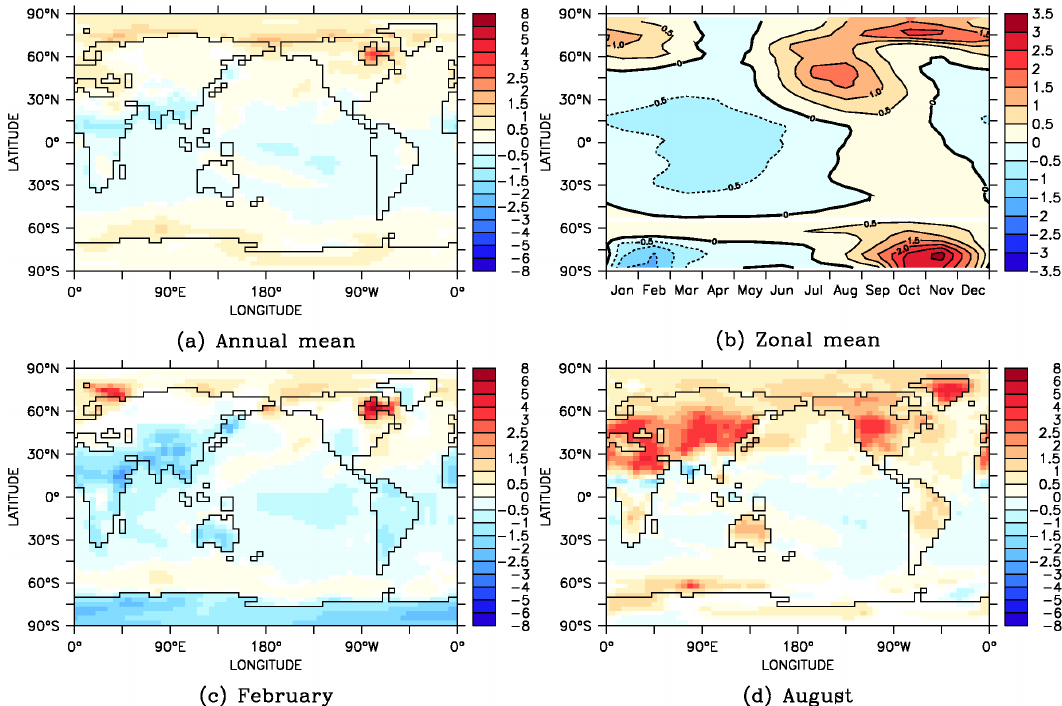
Fig. 2. The average surface air temperature (K) for years 201–1200 of experiment 6KA, expressed as an anomaly relative to CONTROL: (a) the annual mean, (b) the zonal mean, (c) February, and (d) August. In (a) , (c) and (d) , only values that are significant at the 95% confidence level are